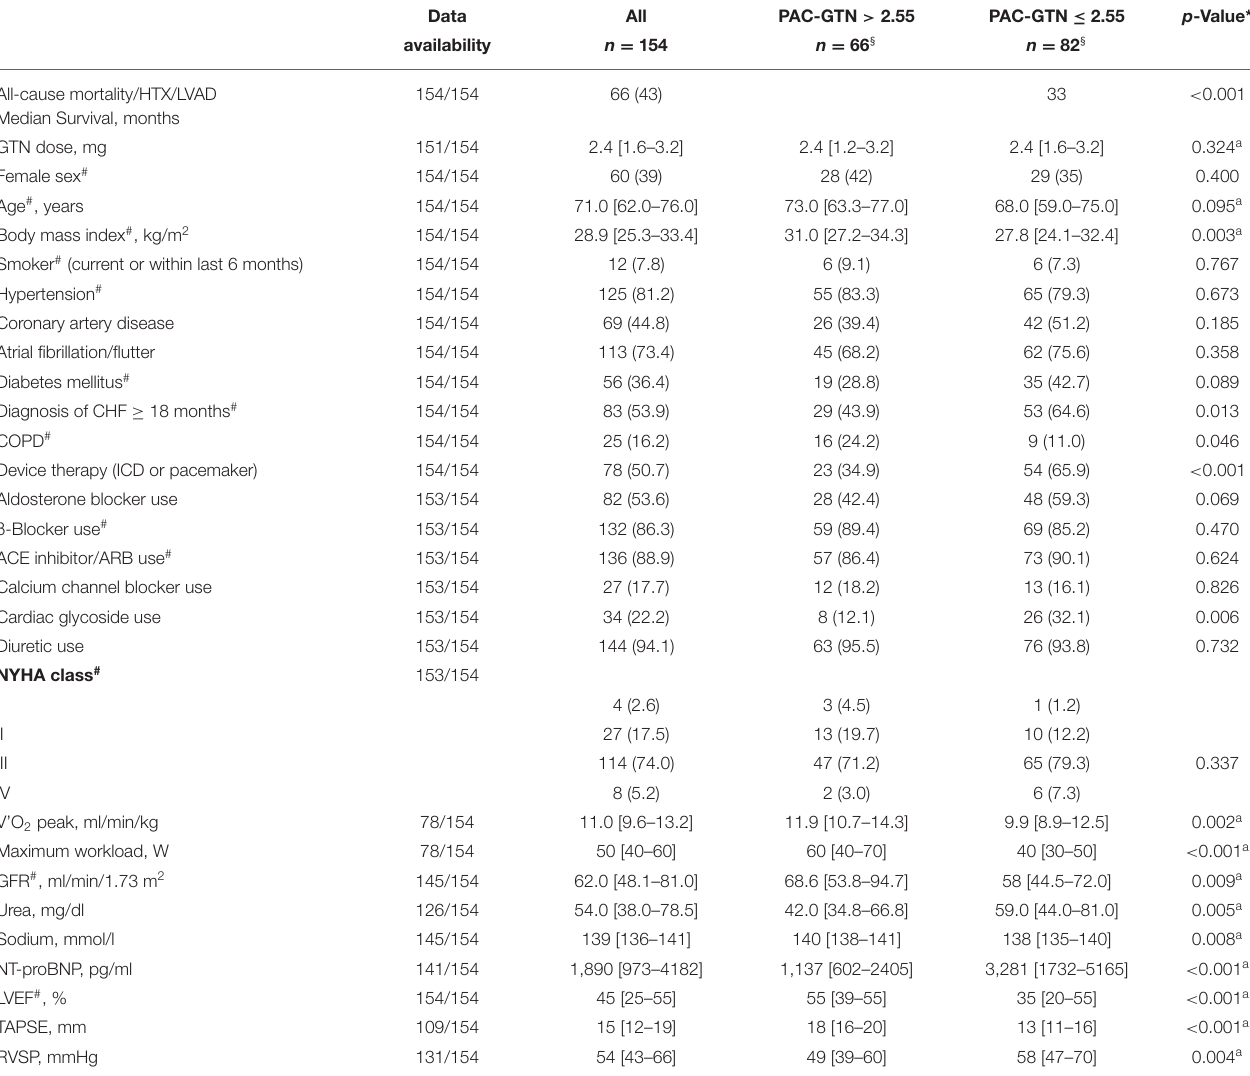
TABLE 1 | Baseline